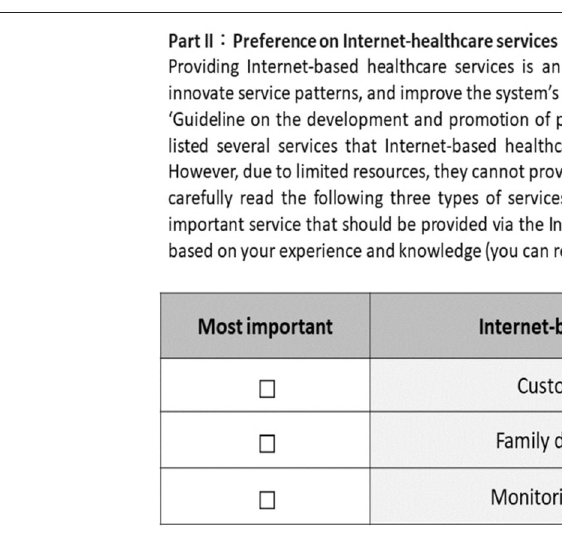
FIGURE 1 | An example of the BWS